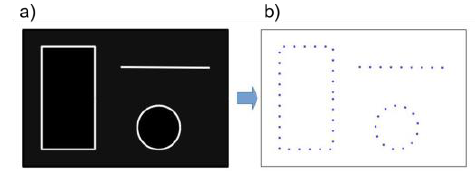
Figure 2. Rectangle, line and circunference a) represented in a CAD file and b) after